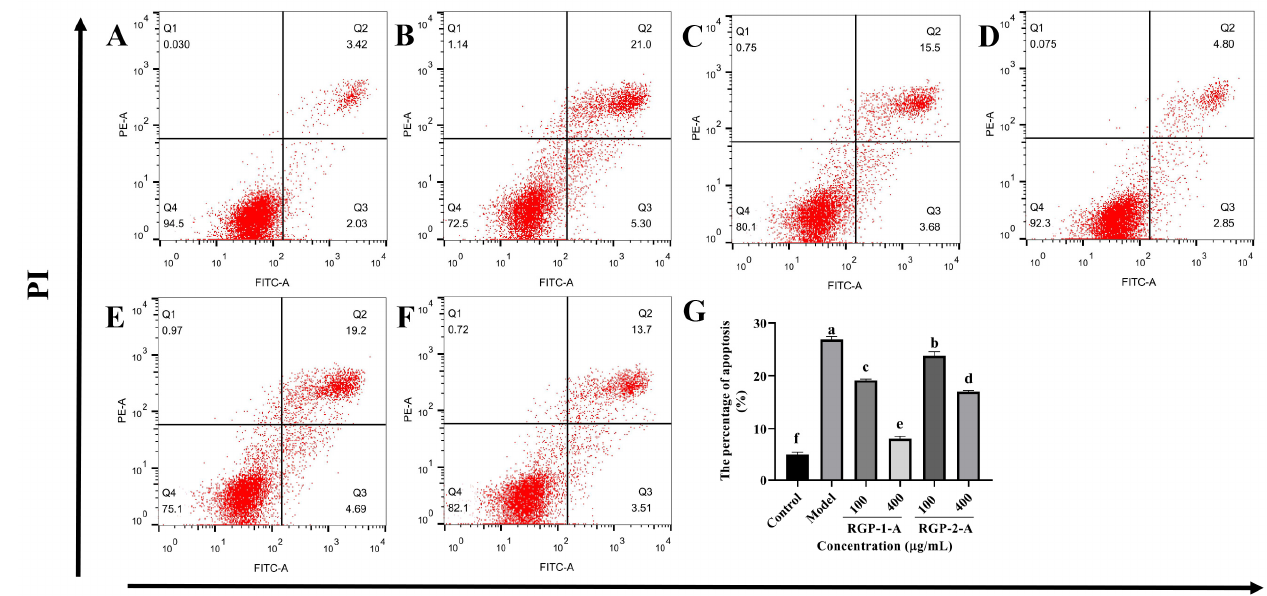
Figure 6. Effect of RGP pretreatment on apoptosis in LPS-induced IPEC-J2 cells. In ( A – F ), ( A ): control group; ( B ): model group; ( C ): RGP-1-A low concentration; ( D ): RGP-1-A high concentration; ( E ): RGP-2-A low concentration; ( F ): RGP-2-A high concentration; ( G ): Quantitative analysis of the number of apoptotic cells. Q1 represents the proportion of dead cells (necrosis), Q2 represents the proportion of late-apoptotic IPEC–J2 cells, Q3 represents the proportion of early-apoptotic IPEC–J2 cells, and Q4 represents the proportion of surviving IPEC–J2 cells. RGP-1-A: decolorized pure polysaccharides of RGP obtained using AB-8 macroporous resin; RGP-2-A: decolorized pure polysaccharides of RGP obtained using H 2 O 2 . On the bar graphs, different lowercase letters signify a significant difference ( p < 0.05).